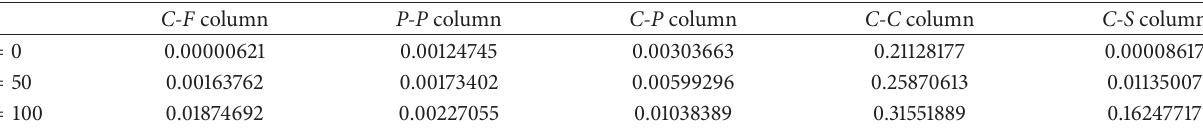
Table 6: Percent relative errors of HAM approximations for the second buckling mode.